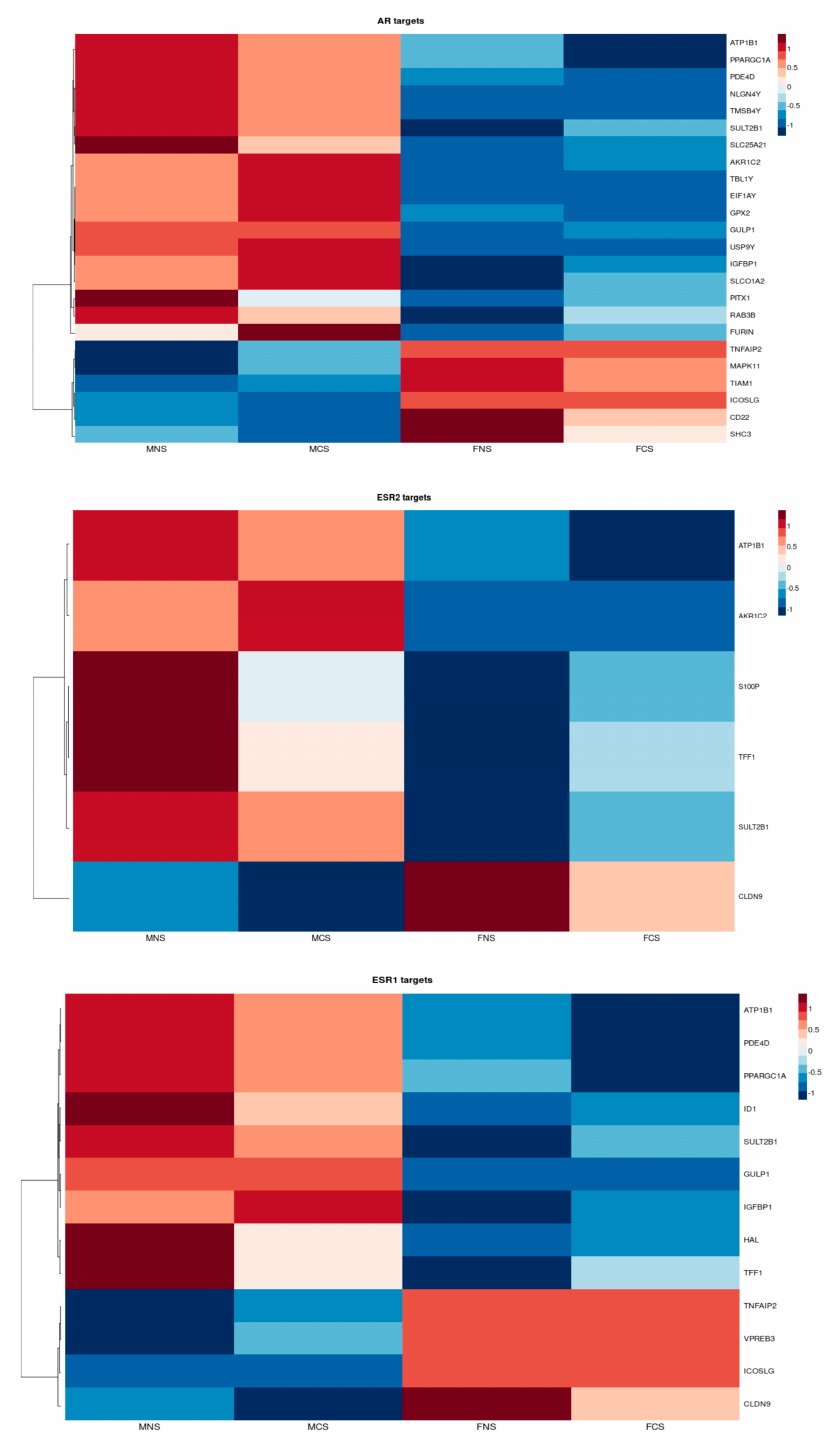
Figure 6. Heatmap reflecting the differential median expression across all the samples according to DEGs encoding androgen and oestrogen transcriptional target in LUAD cohort between male never smokers (MNS), current smokers (MCS), female never smokers (FNS) and female current smokers